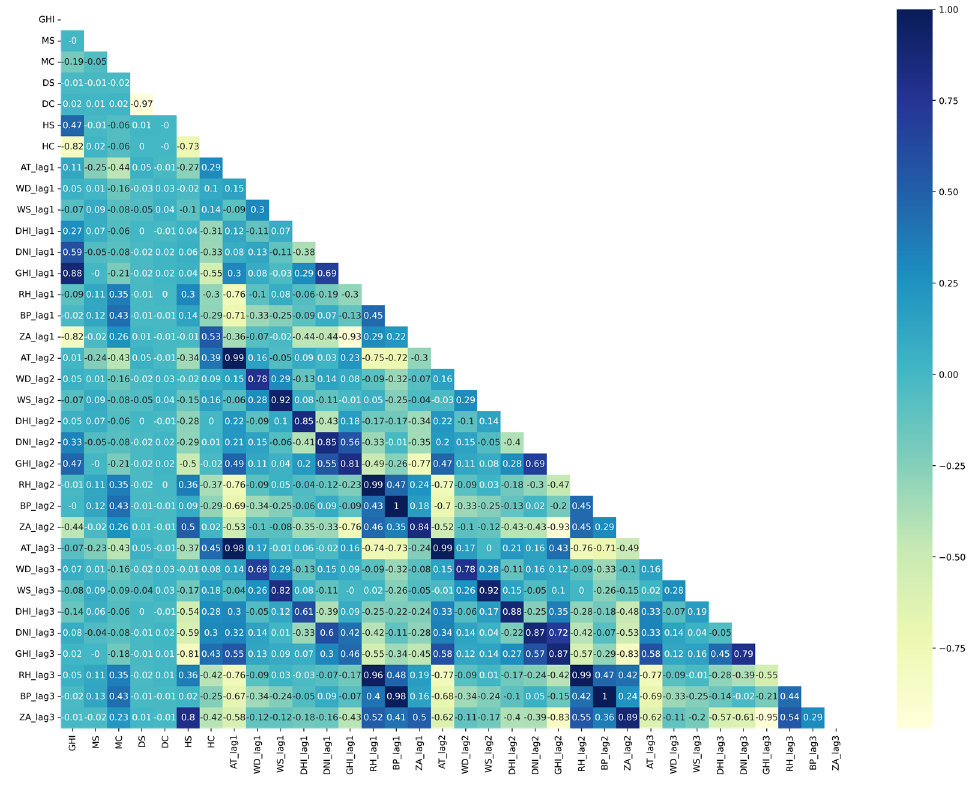
Energies 2022 , 15 , x FOR PEER REVIEW 21 of 72